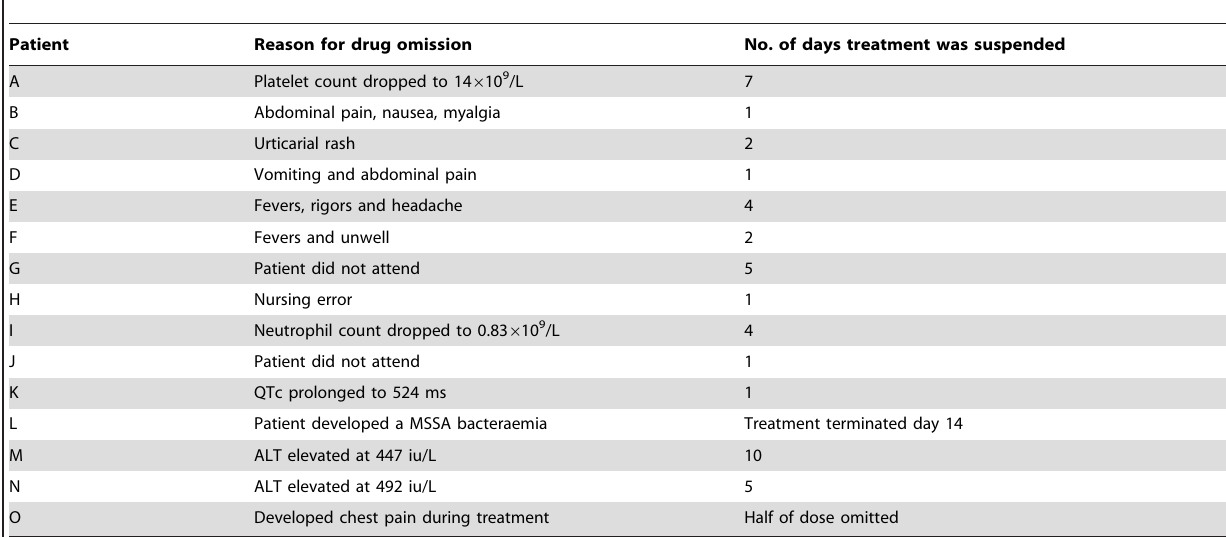
Table 3. Reasons for treatment suspensions and